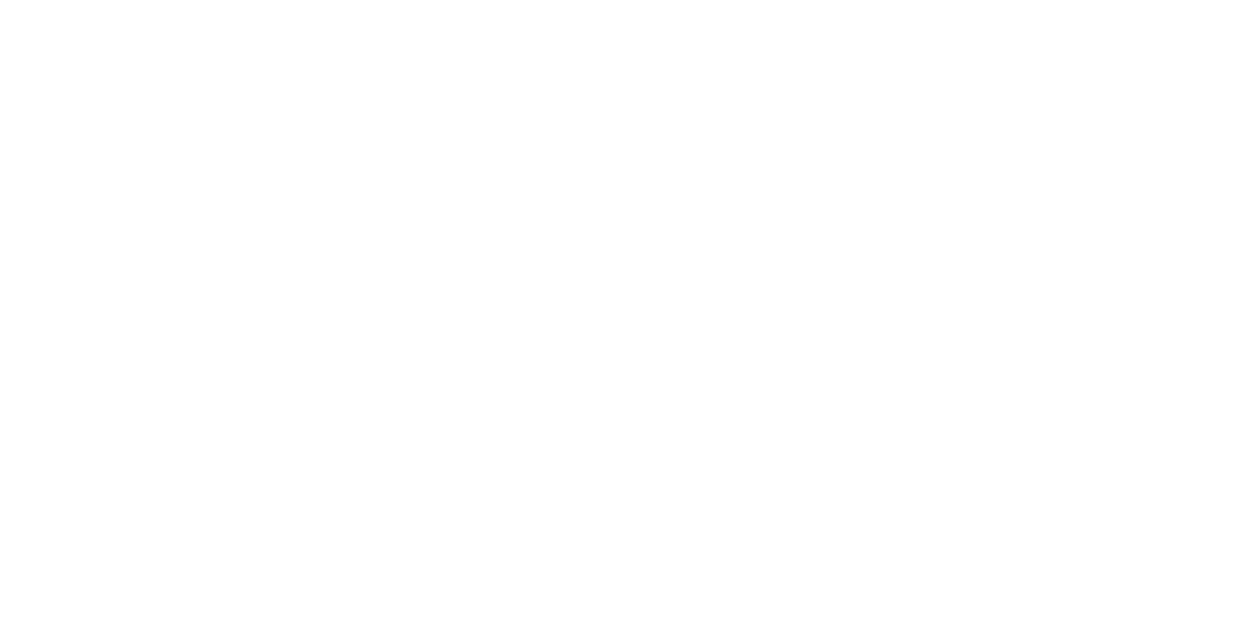
PLOS ONE | DOI:10.1371/journal.pone.0127421 May 26,